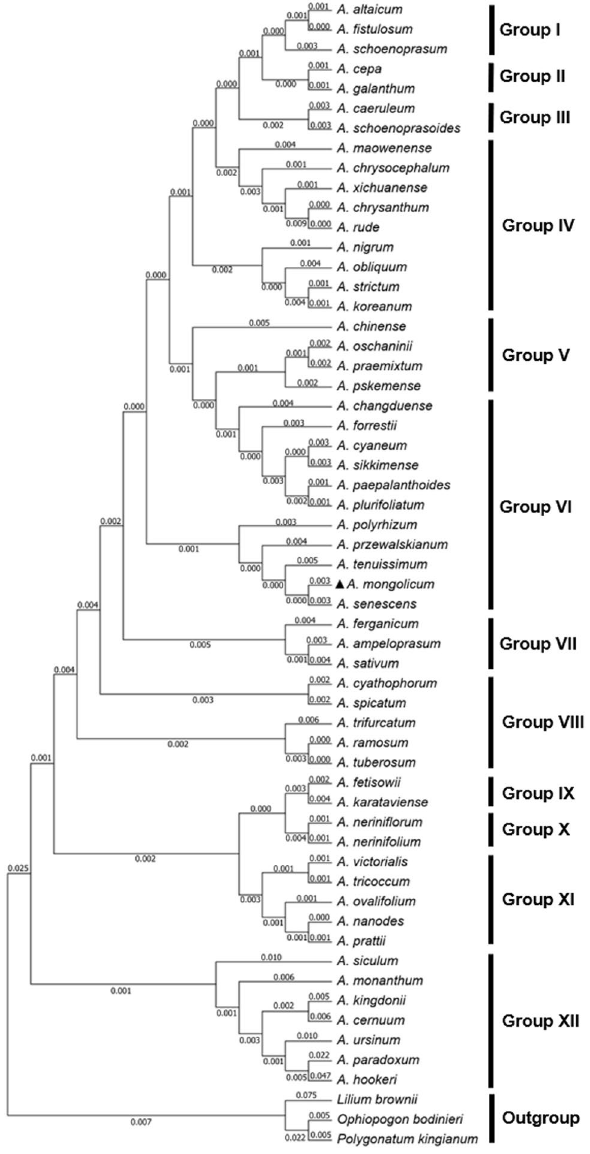
Figure 6. Phylogenetic relationships of 55 Allium species using Maximum Likelihood (ML) analyses, and Lilium brownie (MK493294), Ophiopogon bodinieri (NC_051508) and Polygonatum kingianum (MW373520) were used as the